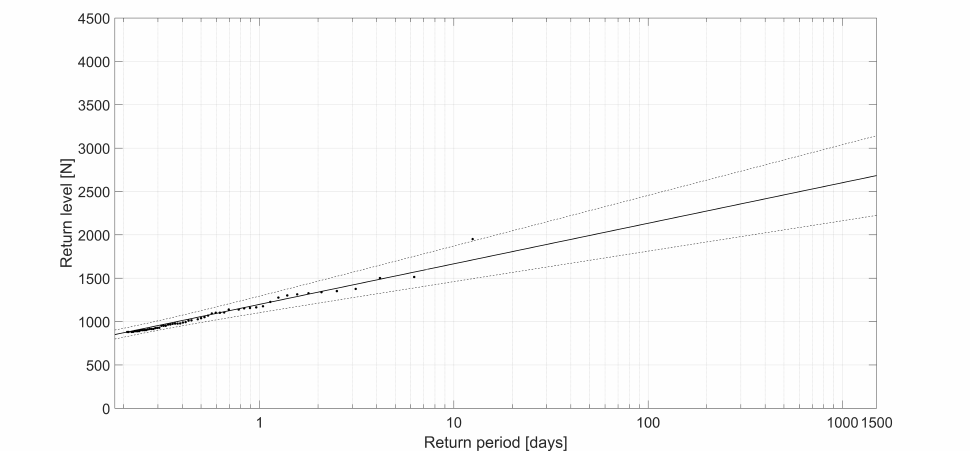
Figure 11. The return level versus return period for extrapolated exponential model for the calm period of the year over 8.94 years (i.e., corresponding to about 20 years for a full-scale system). The dashed lines show the lower and upper bound of the 95% confidence